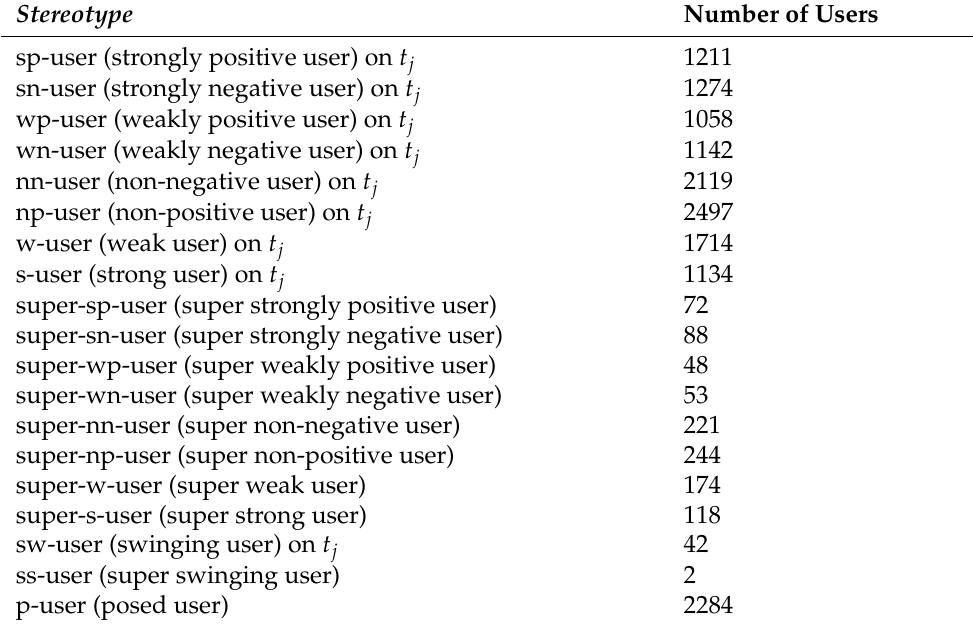
Table 10. Number of users associated with each